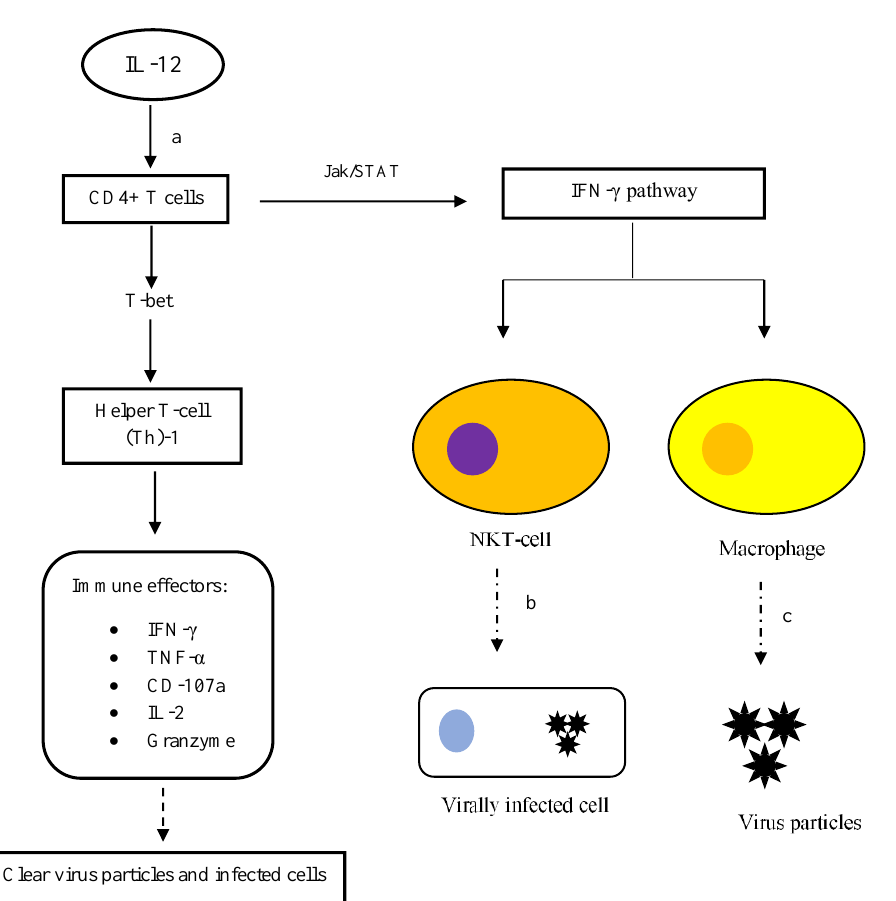
Figure 1. Activation of CD4+ T cells and IFN-γ pathway via IL-12 signalling. ( a ) Upon binding to cell receptors, IL-12 initiates the proliferation of CD4+ T cells into Th-1 cells that subsequently activates immune effectors to further enhance host defence against virus infections. Eventually, clearance of virus particles and infected cells can be carried out by the host immune system. Secondly, the activated Th-1 cells also synthesize IFN-γ via Jak/STAT signalling. The release of IFN-γ into the surroundings encourages the proliferation and activation of macrophages and NK T cells. ( b ) NK T cells are important cellular effectors in eliminating infected cells. ( c ) Once armed, macrophages actively engulf virus particles to prevent virus spread. The dashed-line arrows represent the antiviral activities.